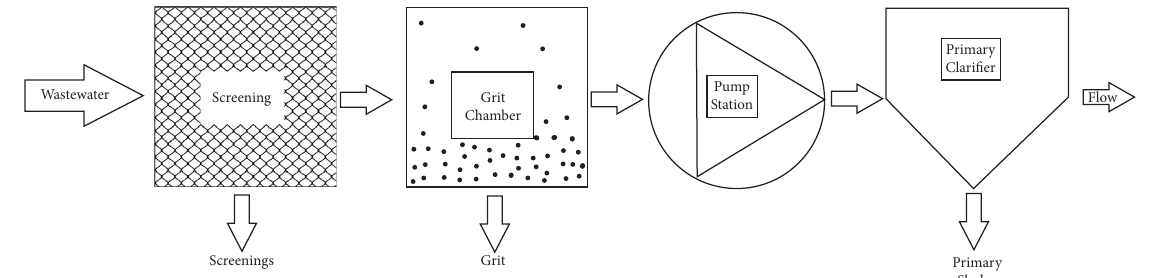
Figure 4: Process diagram for the preliminary treatment